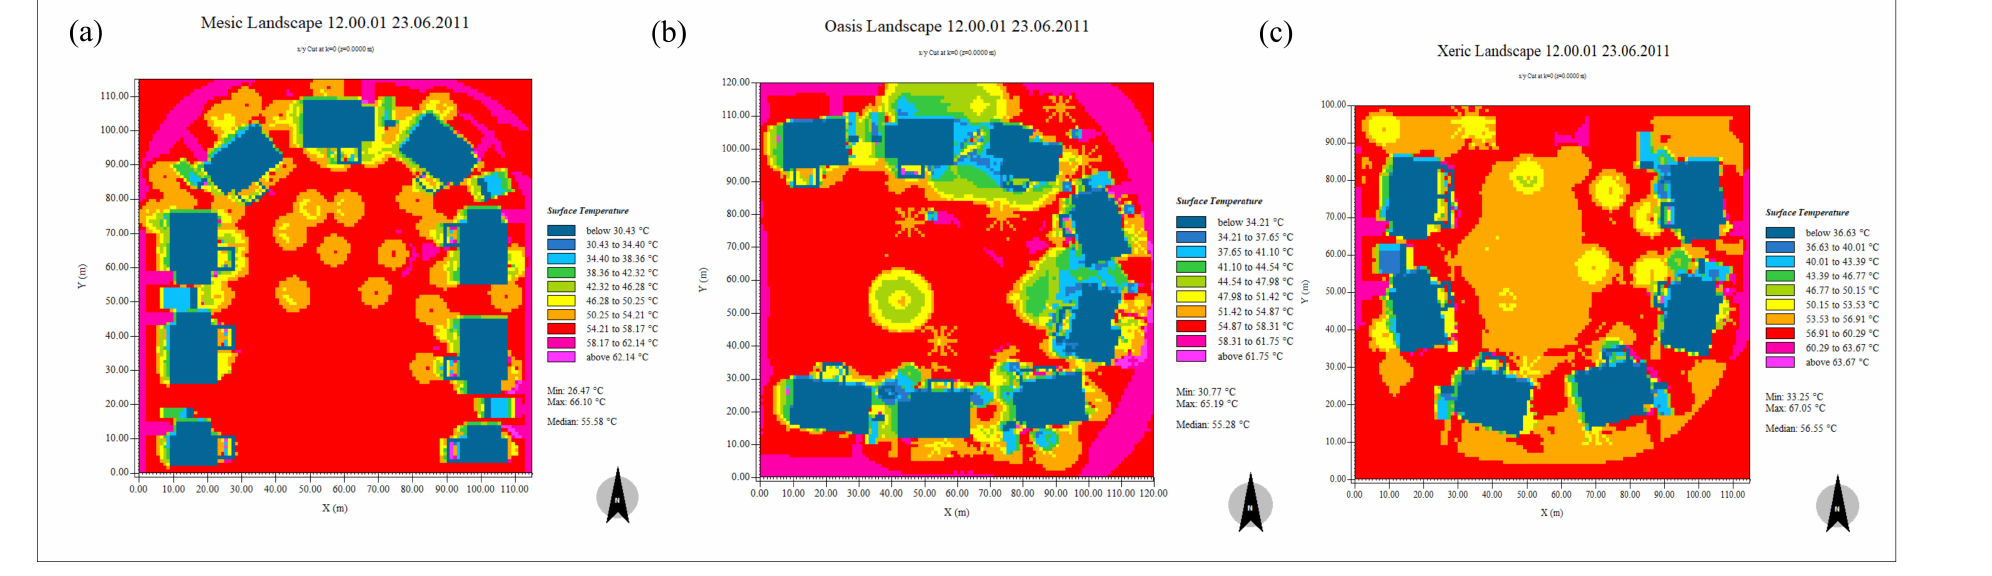
Figure 4. Surface temperatures of the mesic ( a ), oasis ( b ), and xeric ( c ) landscapes at